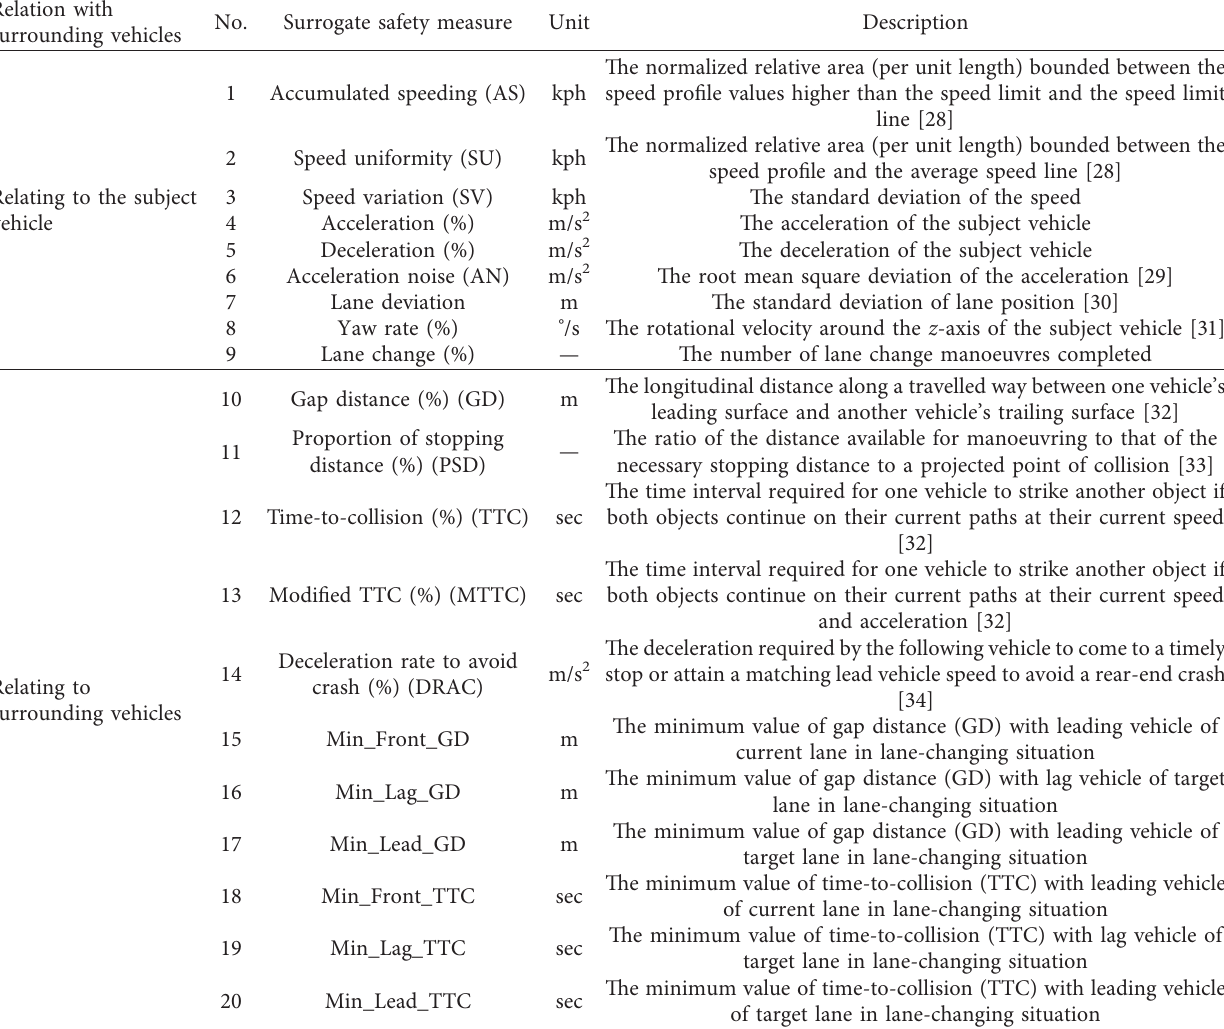
Table 1: Description of implementable surrogate safety